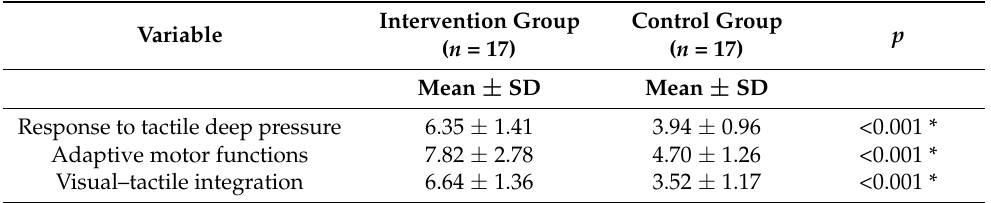
Table 4. Means of TSFI and subheading scores, AIMS score, and eye movement angles and post- treatment comparisons between